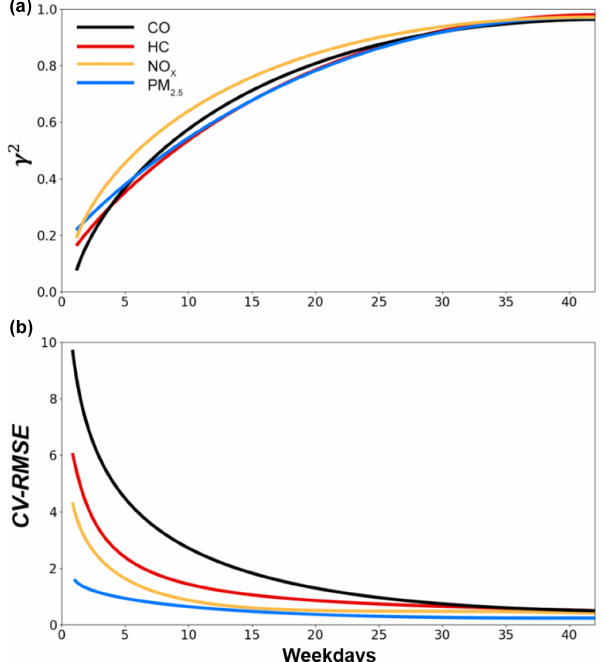
Figure 8. Scaling analysis through systematic subsampling. Using the systematic subsampling algorithm described in Sect. 2.4, we in- vestigated the relationship between the number of drive days and metrics of precision and bias. (a) Mean subsampled γ 2 versus the number of unique weekdays for CO, HC, NO x , and PM 2 . 5 . (b) Mean subsampled coefficient of variation of root-mean-square er- rors (CV-RMSE) versus the number of unique weekdays for CO, HC, NO x , and PM 2 . 5